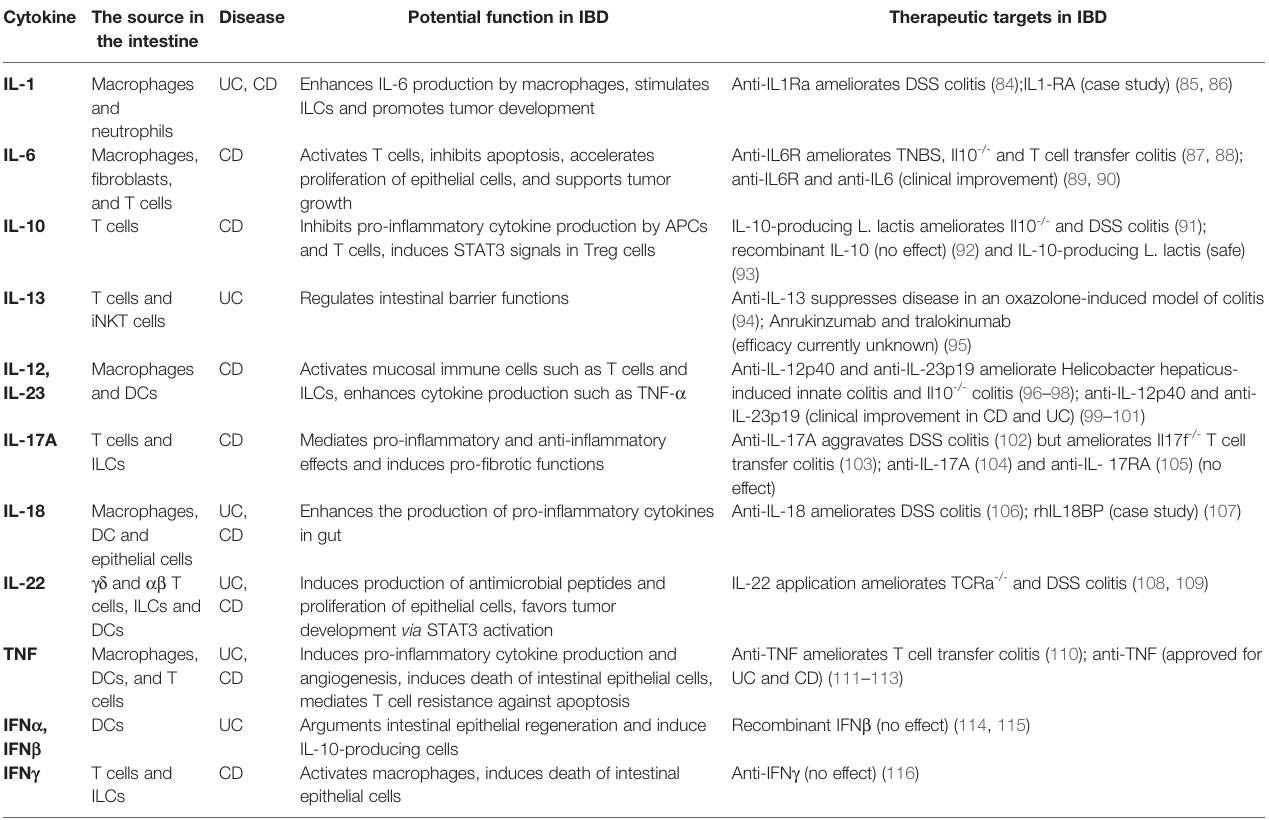
TABLE 2 | Selected key cytokines in in fl ammatory bowel disease. Cytokine The source in Disease Potential function in IBD Therapeutic targets in the intestine